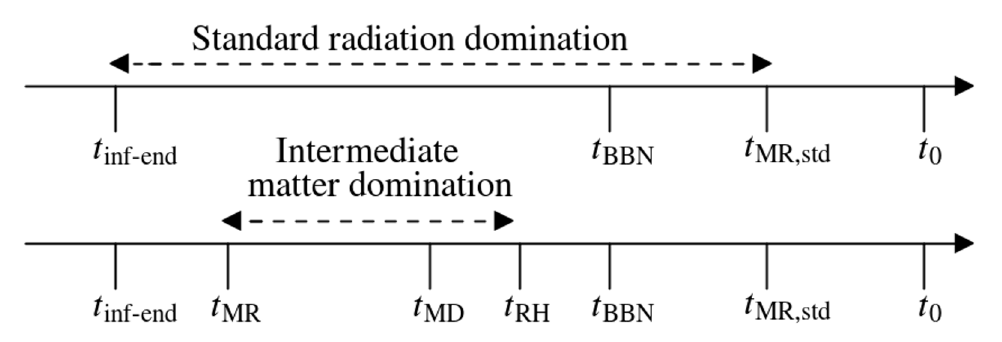
Figure 1 . Schematic description of the cosmological timeline between the end of inflation t inf-end and the present epoch t 0 , in standard cosmology with radiation domination before t MR,std (top panel), and a modified thermal history with an intermediate period of matter domination (bottom panel), with a nearly constant entropy phase between t MR and t MD , and varying entropy phase until t RH , when there is reheating back to RD. See text for